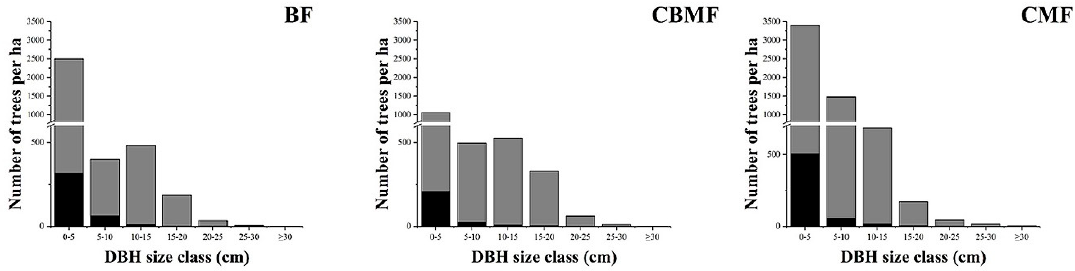
Figure 1. DBH size-class distributions of three forest types. Black bars = dead trees; gray bars = live